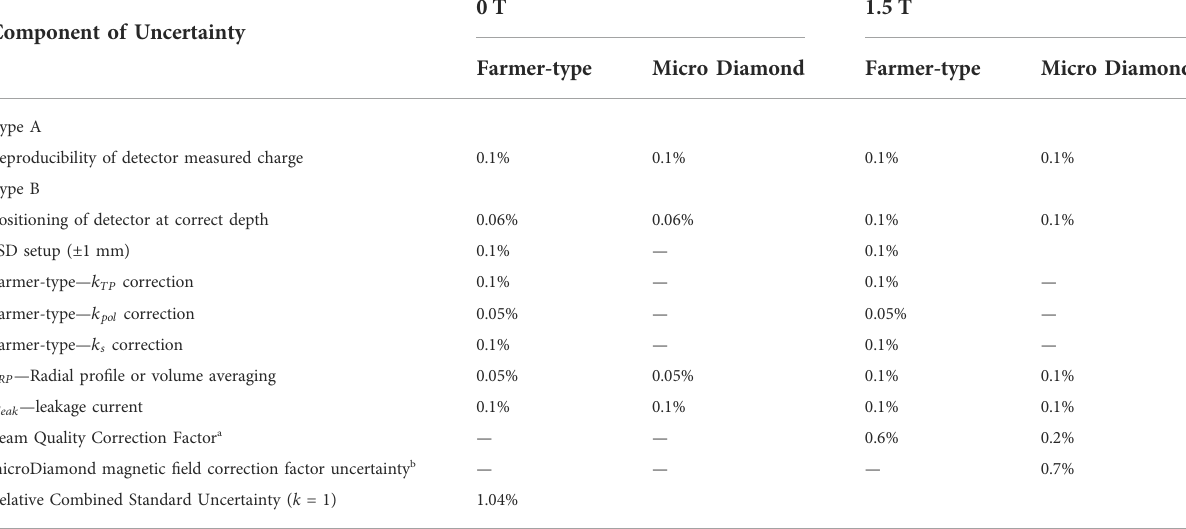
TABLE2Uncertaintyanalysisfor k IC (cid:2) B , Q measurementfromconventionallinactoElektaUnityat1.5 T.Uncertaintieswerecombined via quadraticsum. 2 Component of